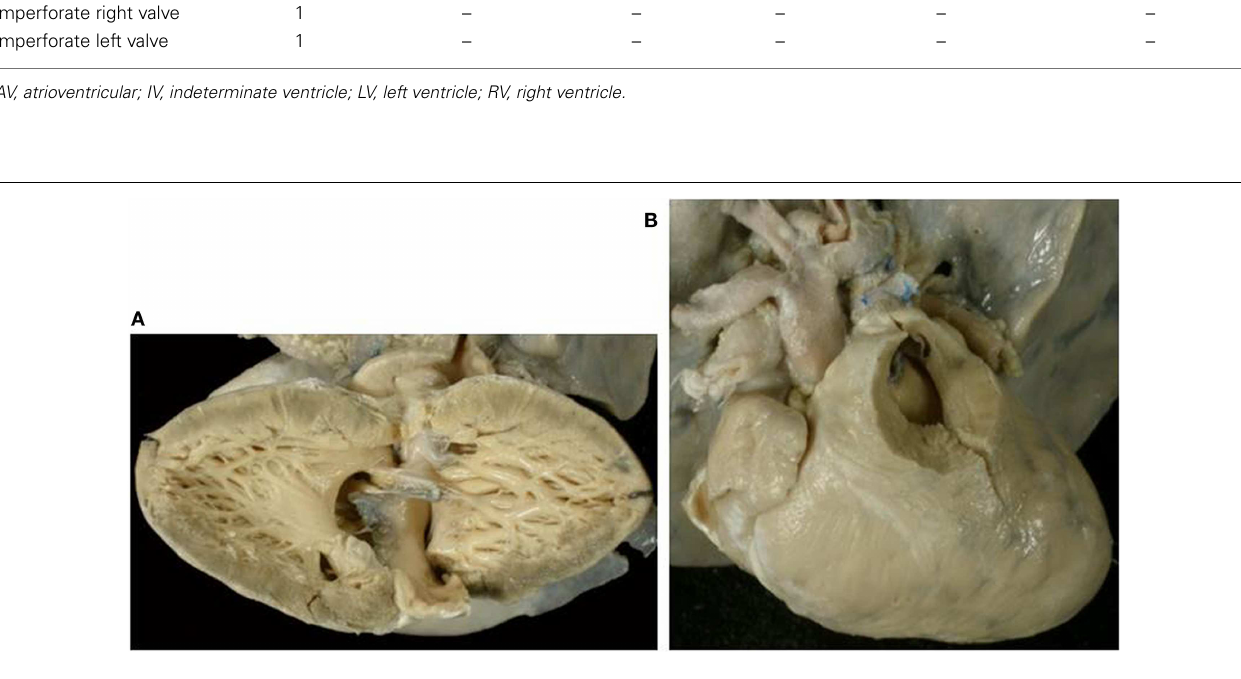
FIGURE 4 | Double inlet left ventricle with concordant ventriculo- arterial connection (Holmes heart) . (A) View of the dominant left ventricle in which both the atria mostly drain through two patent AV valves. (B) External view of the heart with hypoplastic right ventricle and normally